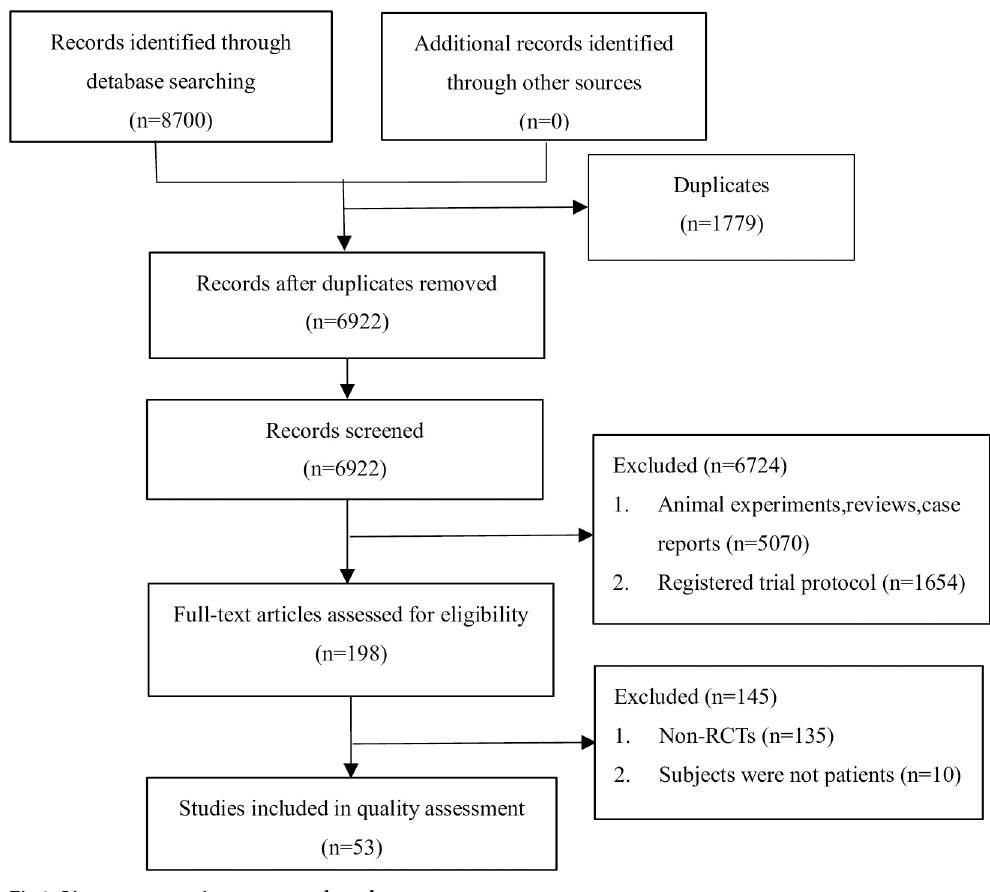
Fig 1. Literature screening process and